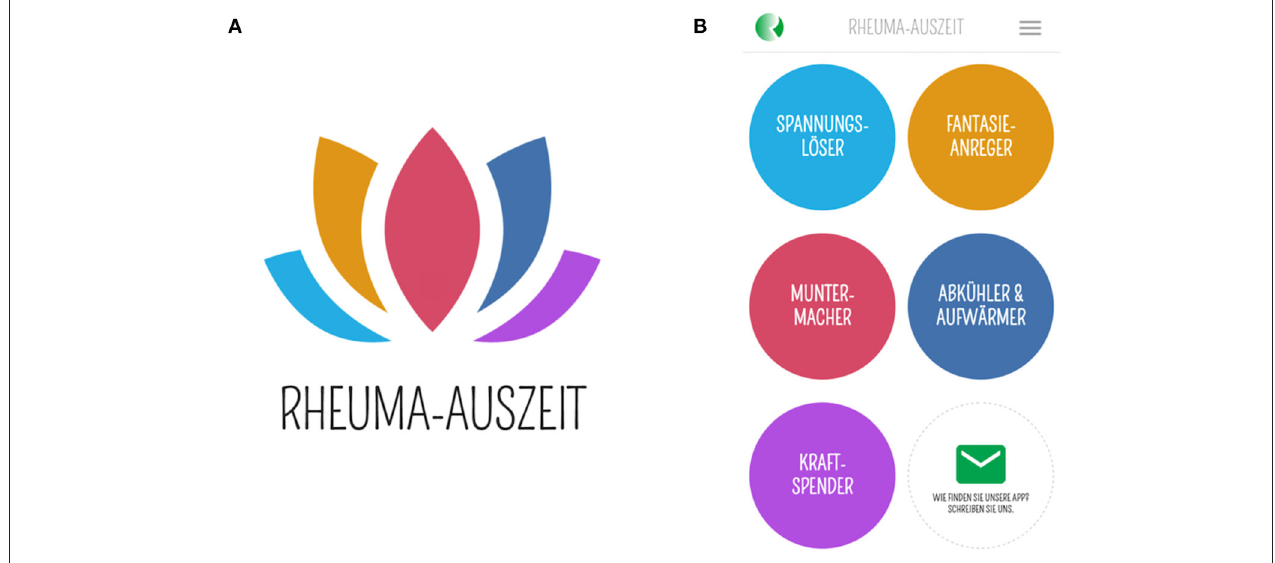
FIGURE 1 | Screenshots of the Rheuma Auszeit app: (A) logo, (B) main menu including the following options: stress relief, imagination stimulator, pick-me-up, cool down & warm up, power donor, feedback. Images provided by the developer, German League against